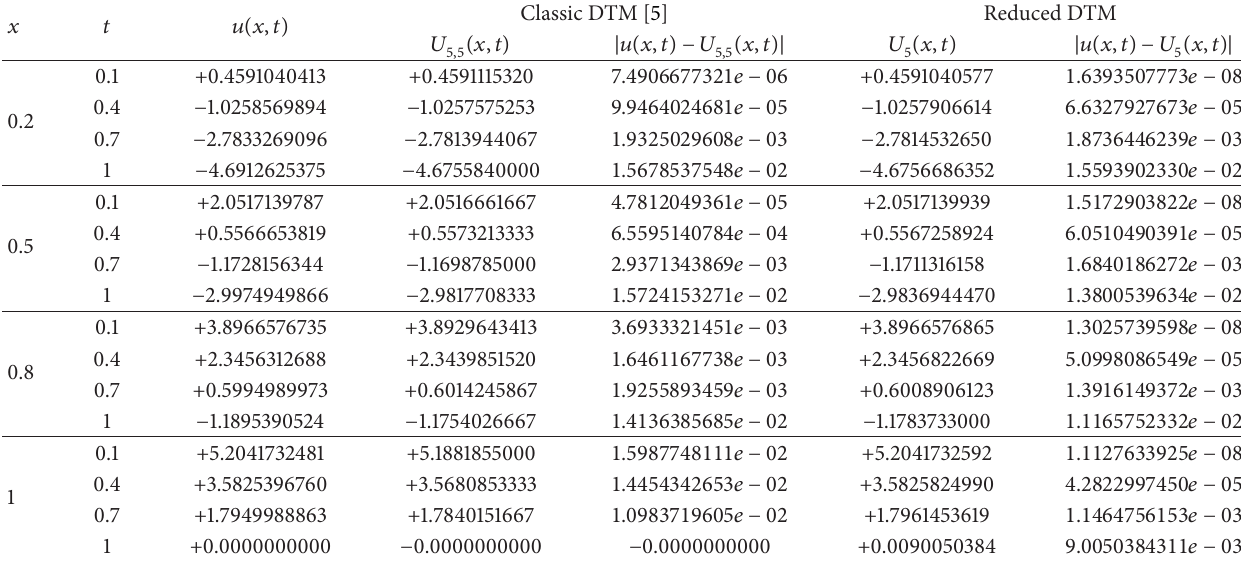
Table 3: Comparisons of the exact solution 𝑢(𝑥,𝑡) = 2(𝑥−𝑡)(2+ sin (𝑥+𝑡)) , with 𝑈 5,5 (𝑥,𝑡) obtained by classic DTM [5] and 𝑈 5 (𝑥,𝑡) obtained by RDTM at some test points (𝑥,𝑡) in Example